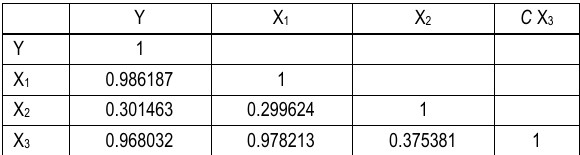
gross profit and mixed income). The values of correlation coefficients, which estimate the correlation between the funding of NGOs and indices of GDP components (according to distribution method), are given in the Table 1. Table 1. The values of correlation coefficients which estimate the correlation between the funding of NGOs and indices of GDP